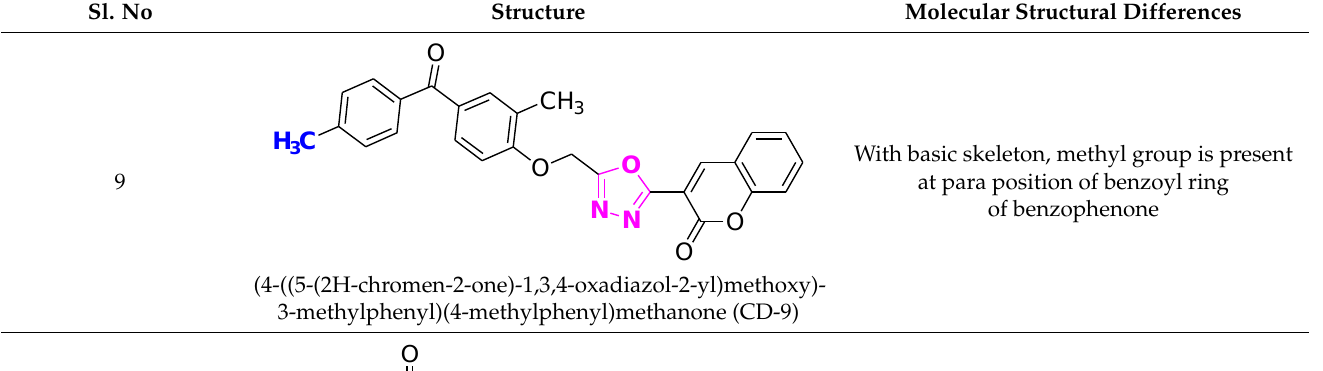
With basic skeleton, iodo group is present